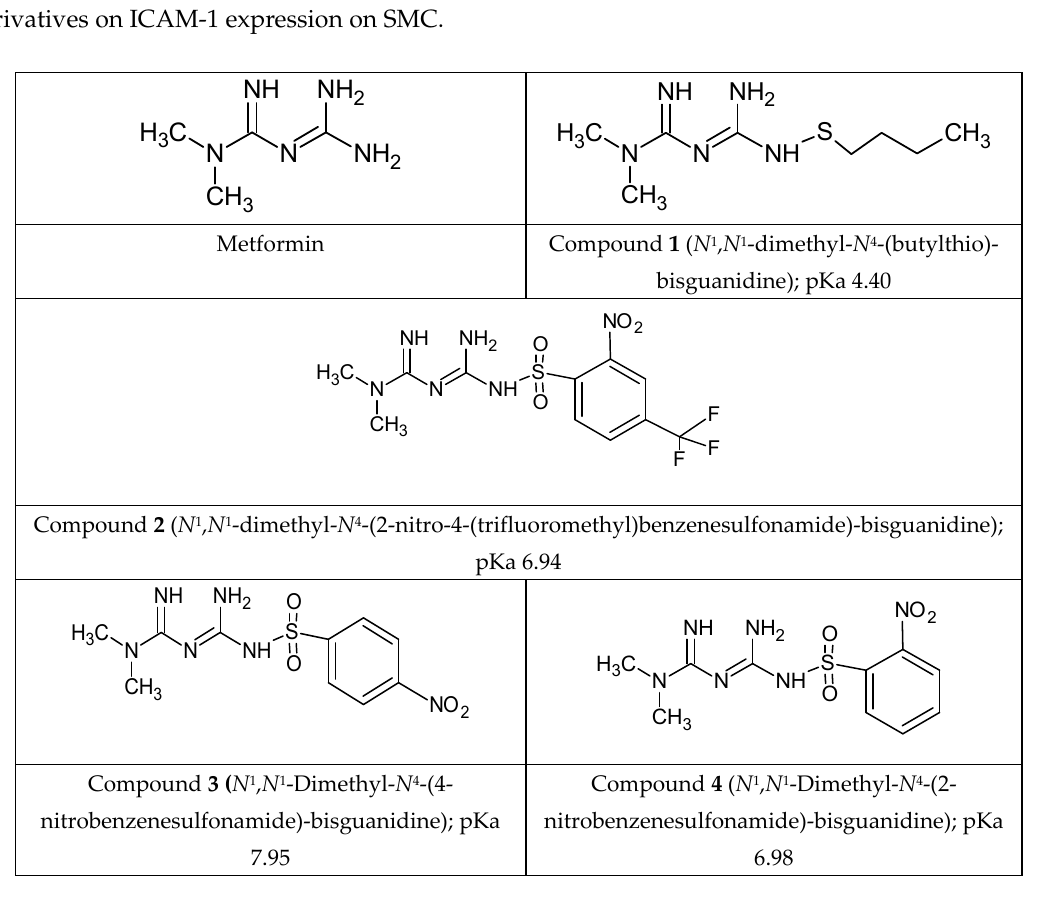
Figure 1. Chemical structure of tested biguanide derivatives – metformin, and compounds 1 – 4 . Compound 1 - N 1 , N 1 -dimethyl- N 4 -(butylthio)-bisguanidine; Compound 2 - N 1 , N 1 -dimethyl- N 4 -(2-nitro-4-trifluoromethylbenzenesulfonamide)-biguanidine, Compound 3 - N 1 , N 1 -dimethyl- N 4 -(4-nitro- benzenesulfonamide)-biguanidine, Compound 4 - N 1 , N 1 -dimethyl- N 4 -(2-nitrobenzenesulfonamide)-biguanidine.